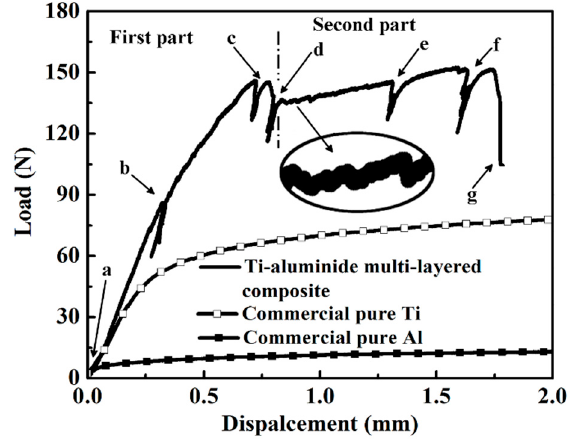
Figure 6. Load-displacement curve of the in-situ three-point bending test.